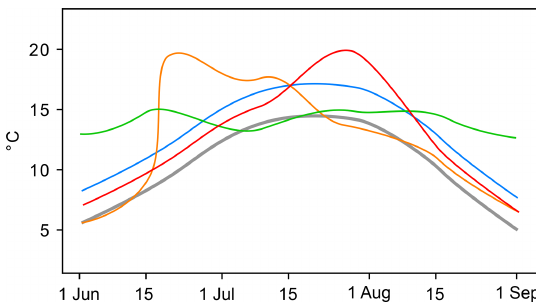
Figure 1. Schematic surface temperature evolution during extreme summers with different substructures: an extreme summer arising from just one heat wave (orange), from a suppression of cool sum- mer days (green), from a shift in the entire T2m distribution (blue) and from a general shift towards higher temperatures and a heat wave (red). The schematic climatological surface temperature evo- lution is depicted in